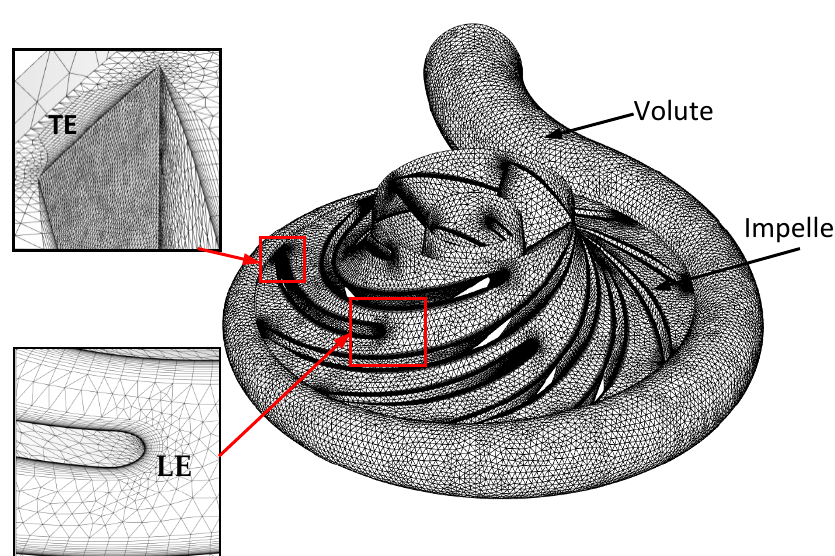
Figure 3. Flow domain mesh.